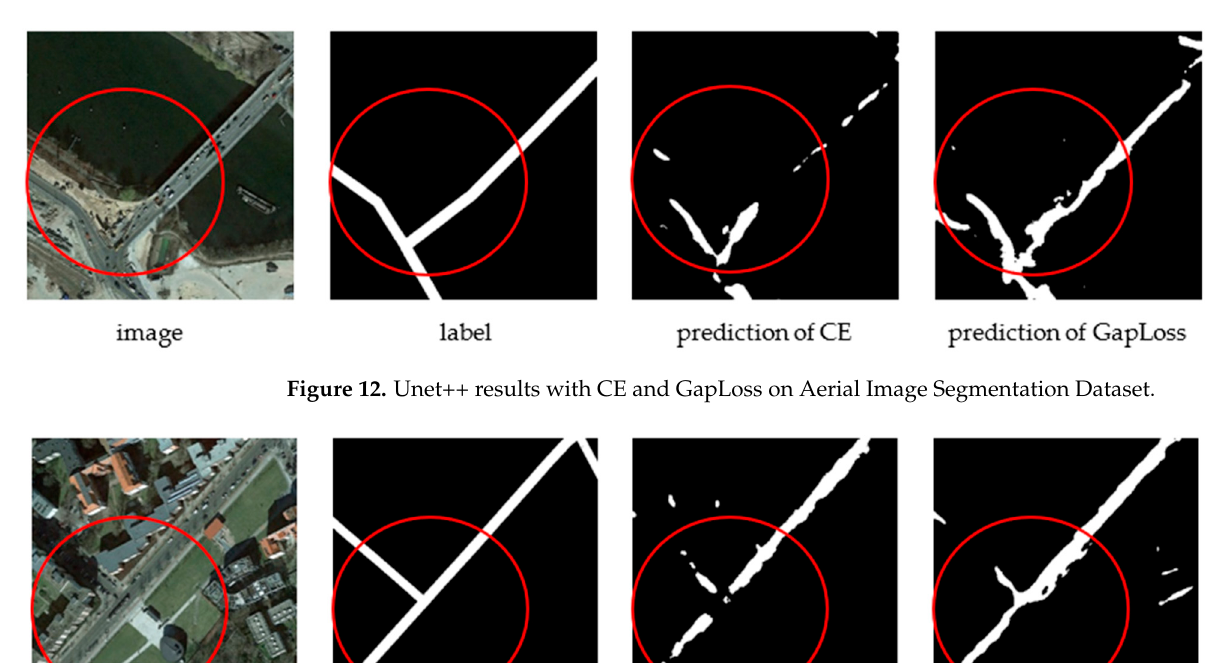
Figure 11. PSPNet results with CE and GapLoss on Aerial Image Segmentation Dataset